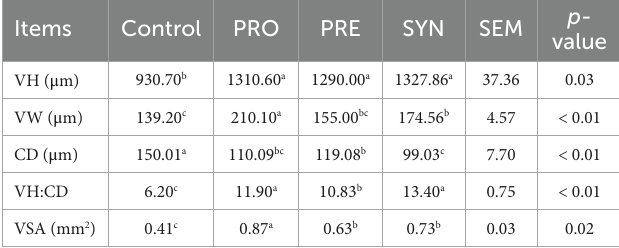
TABLE 6 Effects of dietary treatments on apparent fecal amino acid digestibility coefficient of laying